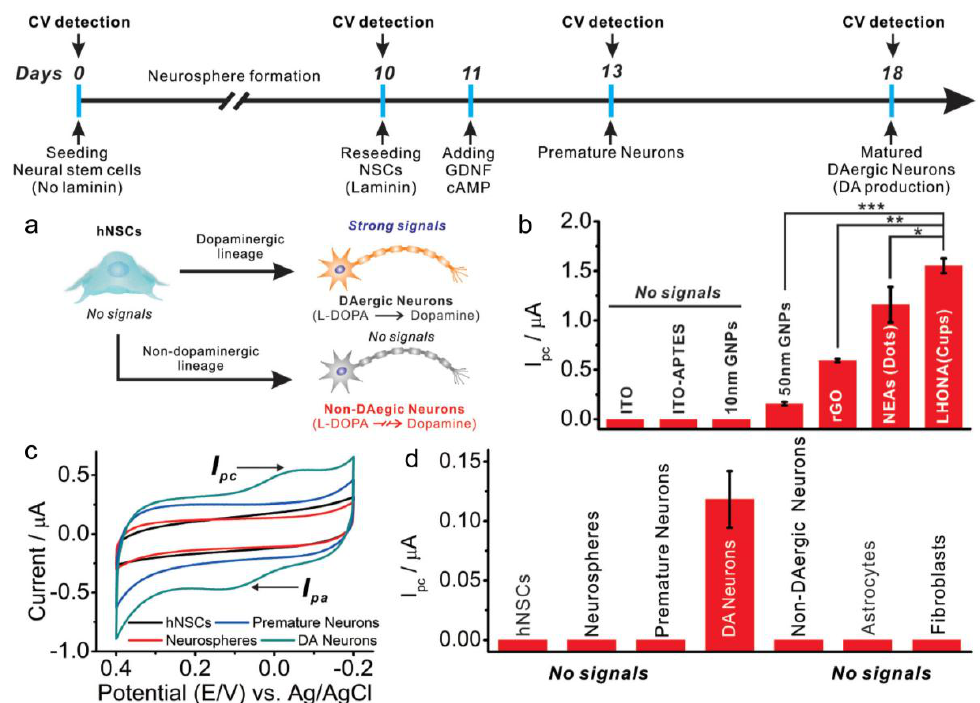
Figure 2. ( a ) Schematic diagram depicting the conversion of human neural stem cells (hNSCs) into dopaminergic (DAergic) and non-DAergic neurons; ( b ) The oxidation peak intensities of dopamine obtained from the CV with various electrodes (Student's t -test, N = 3, * p < 0.05, ** p < 0.01, *** p < 0.001) ( c ) Cyclic voltammogram obtained from cells undergoing differentiation into DAergic Neurons. The result only show completely matured DAergic neurons that reveal clear redox peaks compared to hNSCs, neurospheres, and premature neurons; ( d ) Oxidation peak intensities obtained from ( c ) and other types of cells (astrocytes and fibroblasts) (Modified from Ref. [33] with permission, Copyright 2015 WIELY-VCH Verlag GmbH, Berlin, Germany).